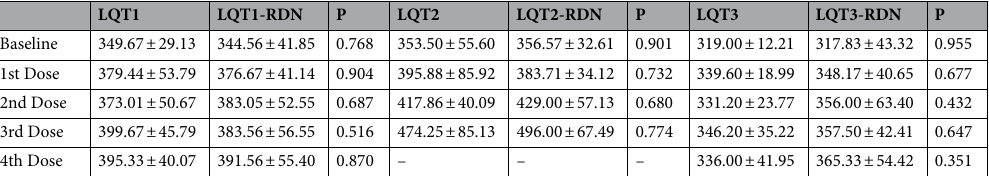
Table 1 demonstrated the sinus rhythm (SR) cycle length (CL) measure- ments from the baseline to the sequentially increased doses for LQT subtype induction. In the LQT1 and LQT1- RDN groups, the SR CL gradually prolonged under sequential doses of HMR-1556 when compared with those at the baseline within each group (Table 1). Similar results of SR CL prolongation were found in the LQT2, LQT2- RDN, LQT3, and LQT3-RDN groups under sequential doses of LQT induction when compared to those at the baseline within each group (Table 1). Under the same LQT subtype induction dose, the SR CL between the LQT and LQT-RDN groups showed no difference in all the LQT subtypes (LQT1, LQT2, and LQT3) (Table 1). Fig- ure 1a illustrated representative examples of ECG under the final LQTS induction dose in all groups. Figure 1b illustrated inducible VAs in the LQT1, LQT2, and LQT3 groups. Table 2 demonstrated the QTc interval meas-